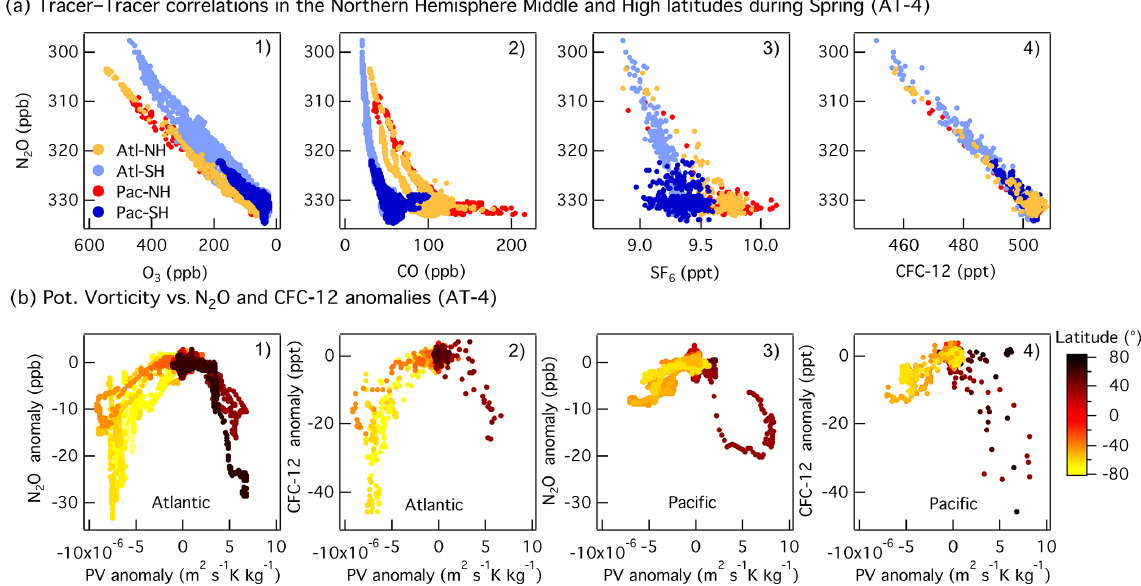
Figure 4. (a) Correlations between N 2 O and O 3 ( a 1), CO ( a 2), SF 6 ( a 3), and CFC-12 ( a 4) at mid- and high latitudes (30–85 ◦ N) during Northern Hemisphere spring (ATom-4). The data are colored as a function of the ocean basin and hemisphere: North Pacific mid–high latitudes (Pac-NH, > 30 ◦ N) in red, South Pacific mid–high latitudes (Pac-SH, < 30 ◦ S) in dark blue, South Atlantic mid–high latitudes (Atl- SH, < 30 ◦ S) in light blue, and North Atlantic mid–high latitudes (Atl-NH, > 30 ◦ N) in orange. Note that the N 2 O and O 3 axes are reversed. (b) Correlations between anomalies in potential vorticity relative to its mean latitudinal distribution in the free troposphere (2–8km) and anomalies in N 2 O ( b 1, b 3) and CFC-12 ( b 2, b 4) as a function of latitude during spring (ATom-4) over the Pacific and Atlantic basins. Mid-latitudes are shown in orange in the SH and in light brown in the